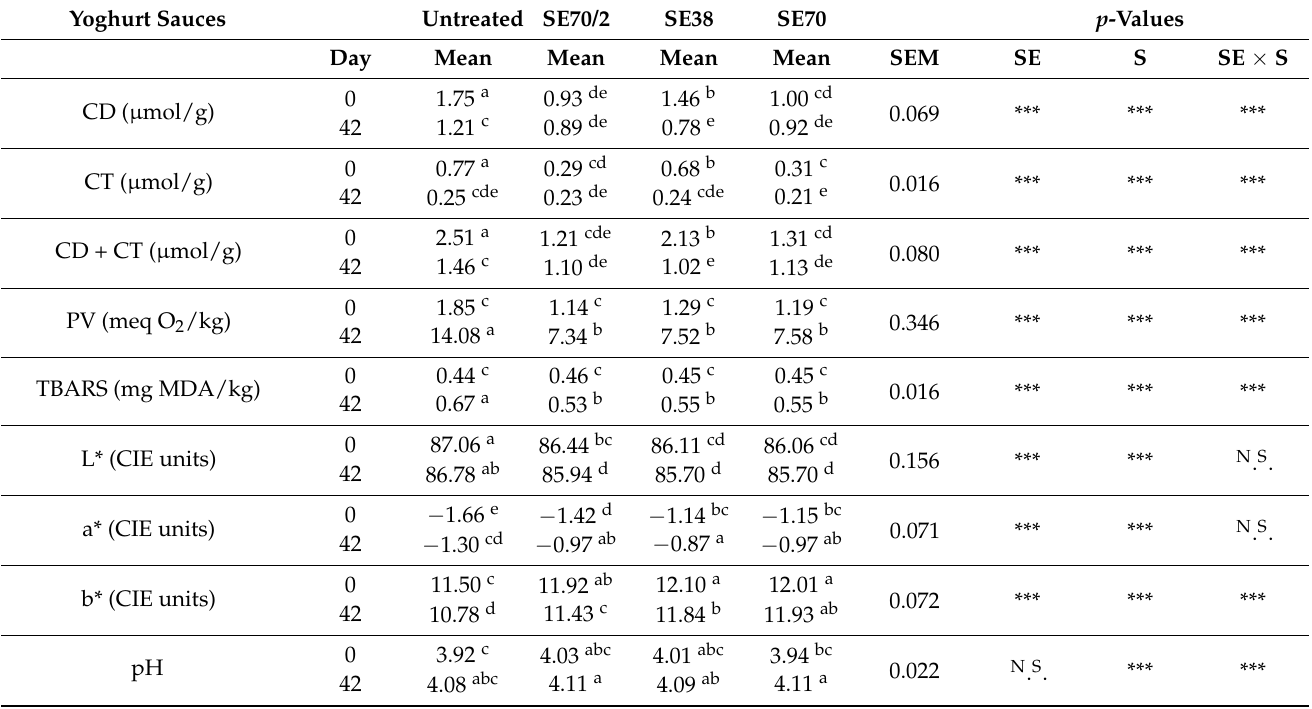
Table 5. Lipid oxidation indexes, CIELab colour, and pH values of yoghurt sauces enriched with sage extracts (SE70/2, SE38, and SE70) and kept at 4 ◦ C for 42